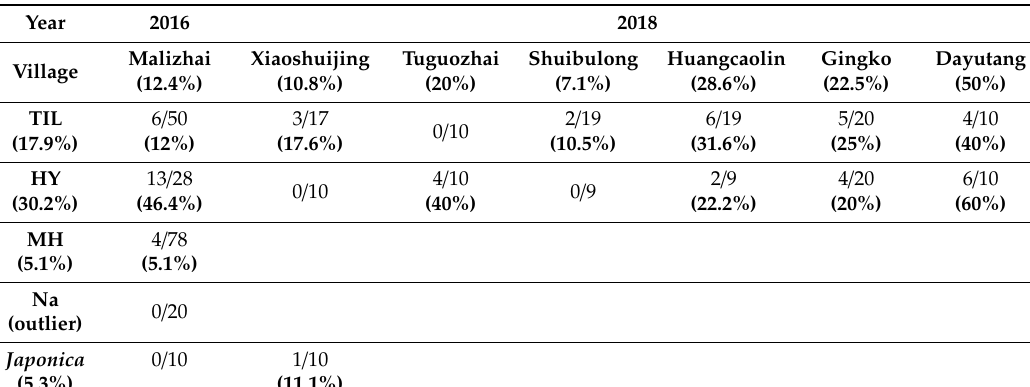
Table 2. Screening of rice samples from the Yuanyang rice terraces of China for the presence of Southern rice black-streaked dwarf virus using qPCR assays. Rice varieties are grouped in rice variety groups (rows) or villages from which they were collected (columns). HY: Hongyang improved modern variety group, MH: modern hybrid variety group, TIL: traditional indica landraces group and Na: not assigned. SRBSDV prevalence is indicated within brackets and bold